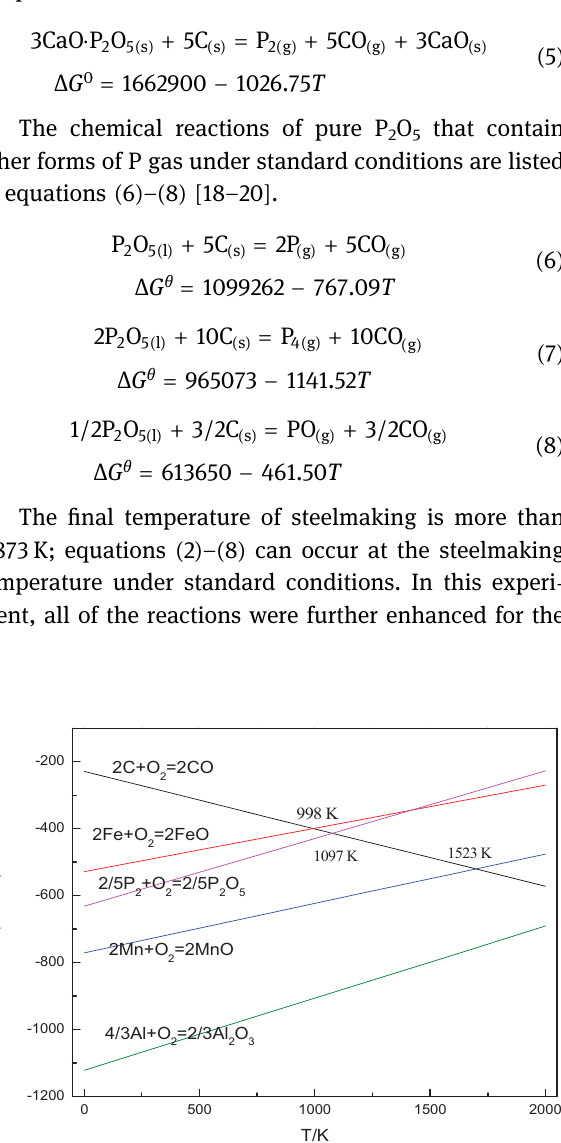
slag is showed in equation ( 5 ) , and the starting reaction